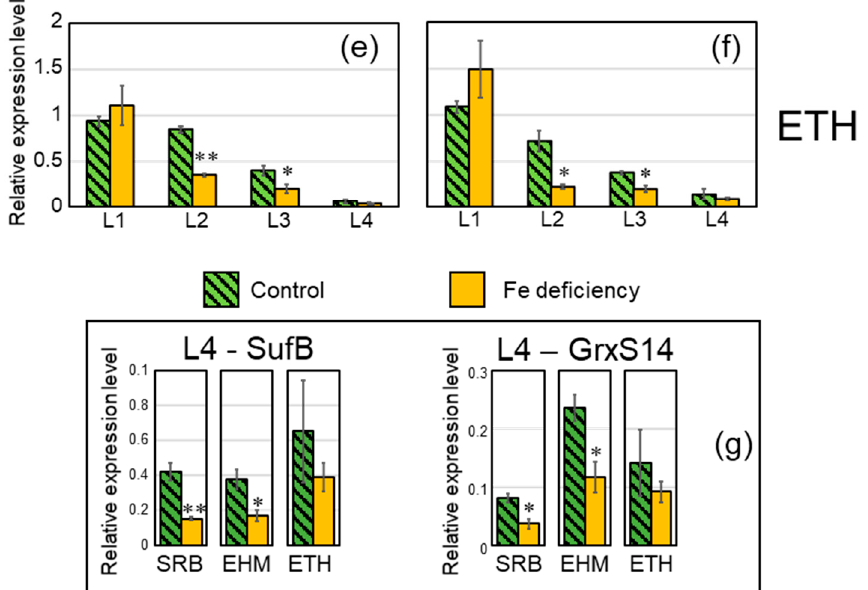
Figure 4. Downregulation of SUFB and GrxS14 at day four after the onset of Fe depletion. Relative expression values were obtained from qRT-PCR performed on total cDNA of leaf samples collected from the same plants as those of Figure 1. Each sample of the three biological replicates was subjected to triplicate experiments, and expression levels of SUFB and GrxS14 were normalized against those of EF-1 α and actin . Error bars indicate the standard error of the three biological replicates. * p < 0.05 and ** p < 0.01 indicate significant differences (according to Student’s t -test) between the control leaf and Fe-deficient leaf. ( a , b ) SRB, ( c , d ) EHM, and ( e , f ) ETH. ( a , c , e ) SUFB and ( b , d , f ) GrxS14 . Enlarged L4 data are shown in panel ( g ).